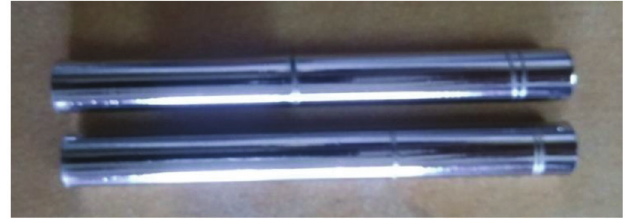
Fig. 1. Thin fi lm nickel coated electrode.